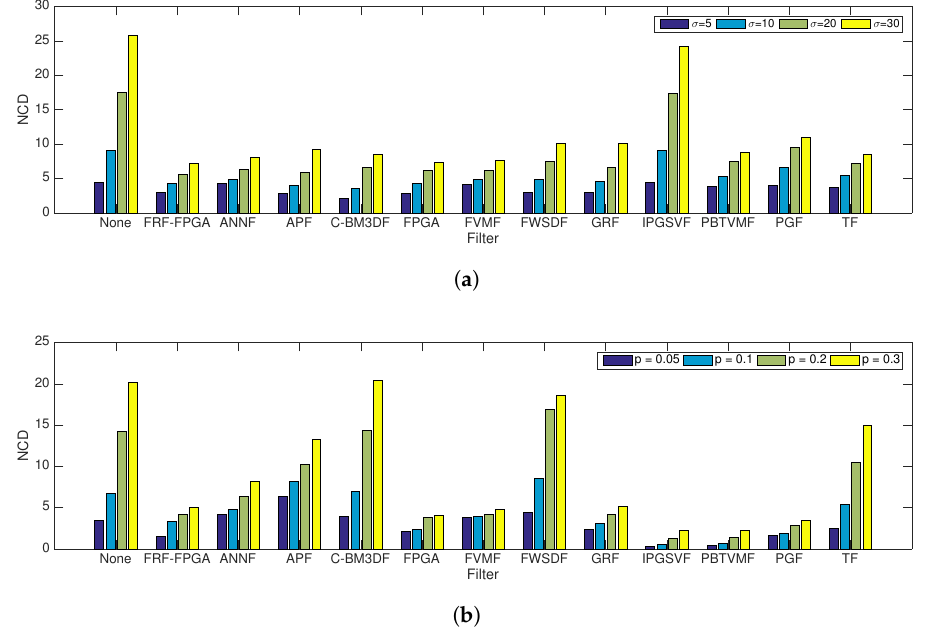
Figure 10. Comparison of normalized color difference (NCD) obtained by state-of-the-art methods when restoring Lena contaminated only with Gaussian noise σ or impulse noise p . ( a ) Lena contaminated only by Gaussian σ . ( b ) Lena contaminated only with impulse p